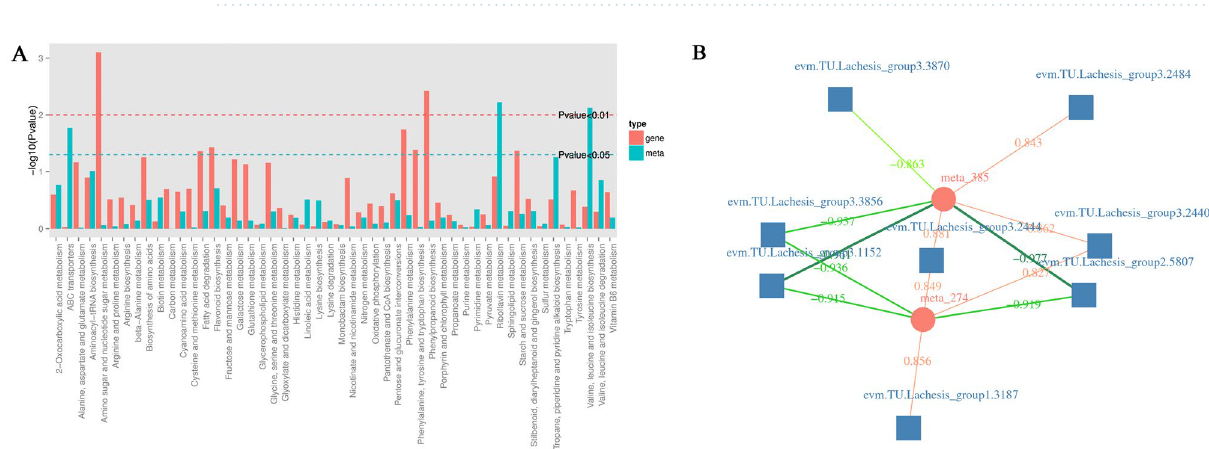
Figure 5. Combined metabolome and transcriptome correlation-analysis diagram. ( A ) Co-enrichment histogram of differential metabolites and DEGs (BCYC vs. BCZC). ( B ) Correlation network diagram. Circles represent metabolites, boxes represent genes, and values on the lines represent correlation coefficients, with positive correlation shown in red and negative correlation in green. A larger correlation coefficient corresponded with a wider line and darker color. meta_274: pinobanksin. CHS : evm.TU.L achesis_group1.3187; evm.TU.Lachesis_group3.2440; evm.TU.Lachesis_group3.2444. CCoAOMT : evm.TU. Lachesis_group3.1152. HCT : evm.TU. Lachesis_group2.5807. CYP73A : evm.TU.